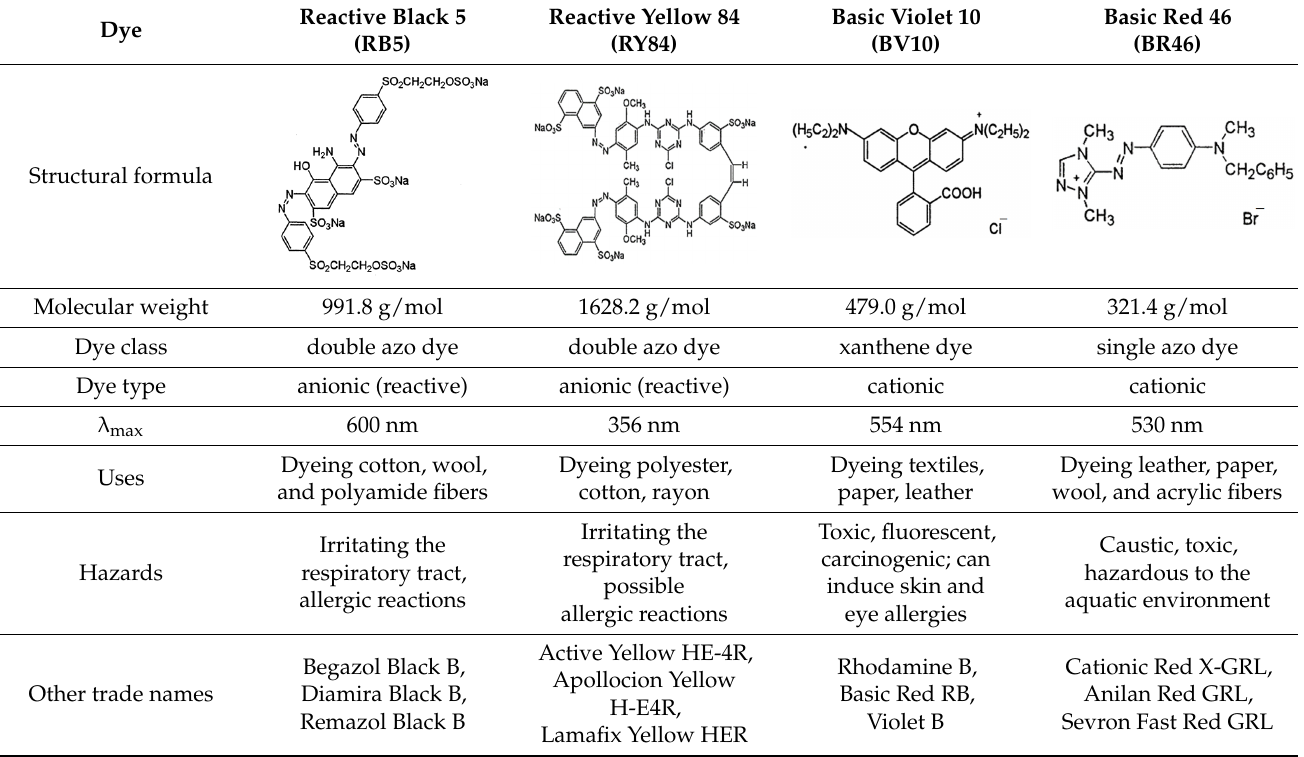
Table 1. Characteristics of the dyes used in the study.